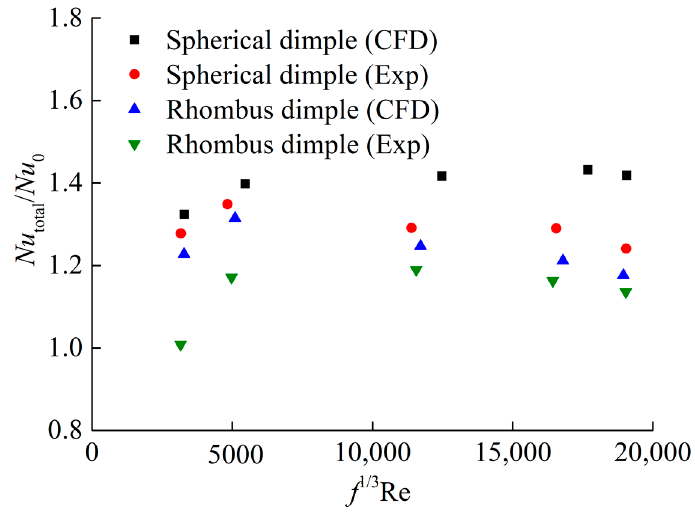
Machines 2021 , 9 , x FOR PEER REVIEW Figure 18. Comparisons of overall thermal performance of the dimpled channels. Figure 18. Comparisons of overall thermal performance of the dimpled channels.